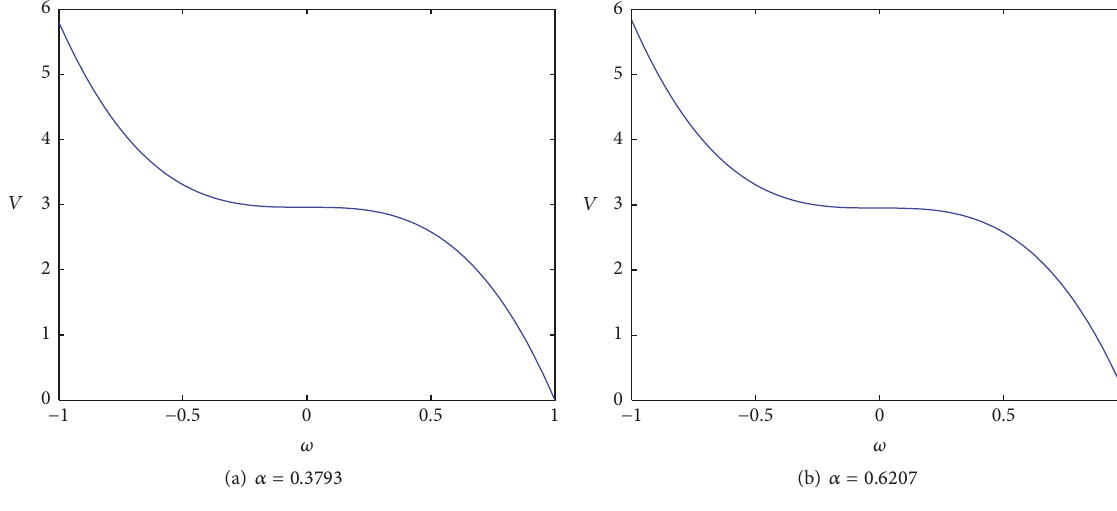
Figure 1: The 𝜔 -curve.